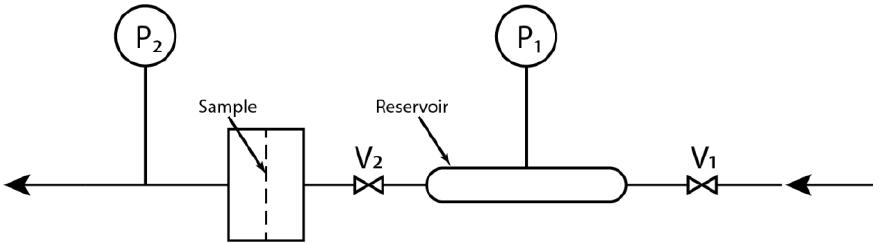
Figure 4. Scheme of the apparatus used to determine BP material’s permeability for hydrogen. Gas is filled into the reservoir by valve V 1 . Then, the reservoir is connected by opening valve V 2 to the chamber with the sample. The pressure sensor P 1 records the pressure in the reservoir. The pressure sensor P 2 measures the atmospheric pressure.